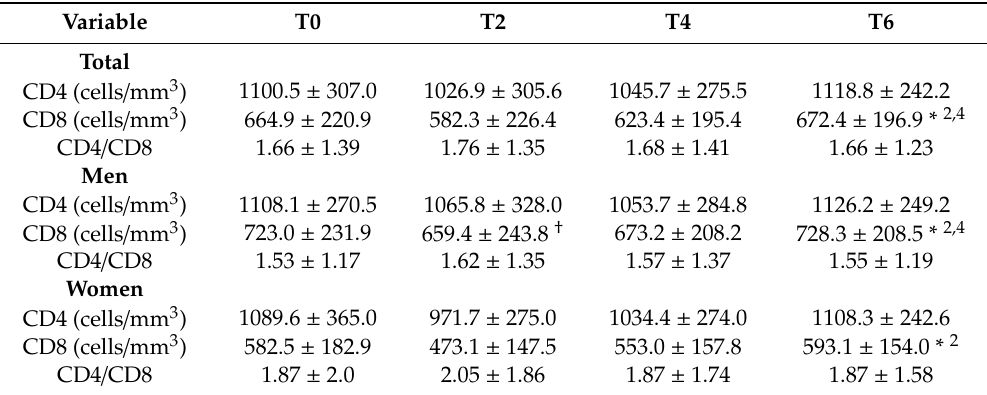
Table 4. Mean ± standard deviations of lymphocytes CD4 and CD8 values at di ff erent measurement